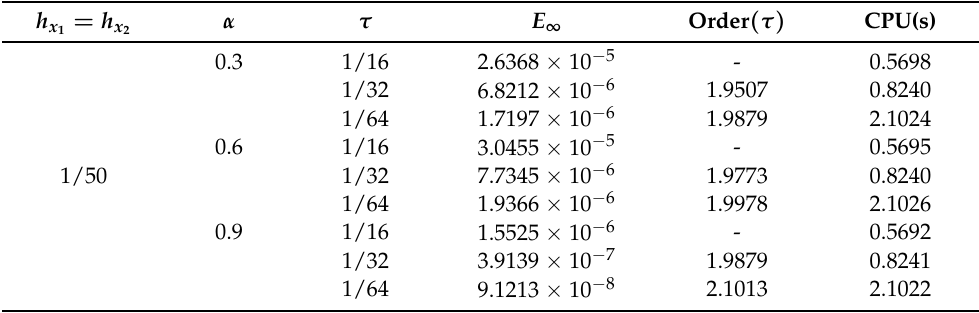
Table 1. The maximum error and convergence order in time-dimension for example 1.